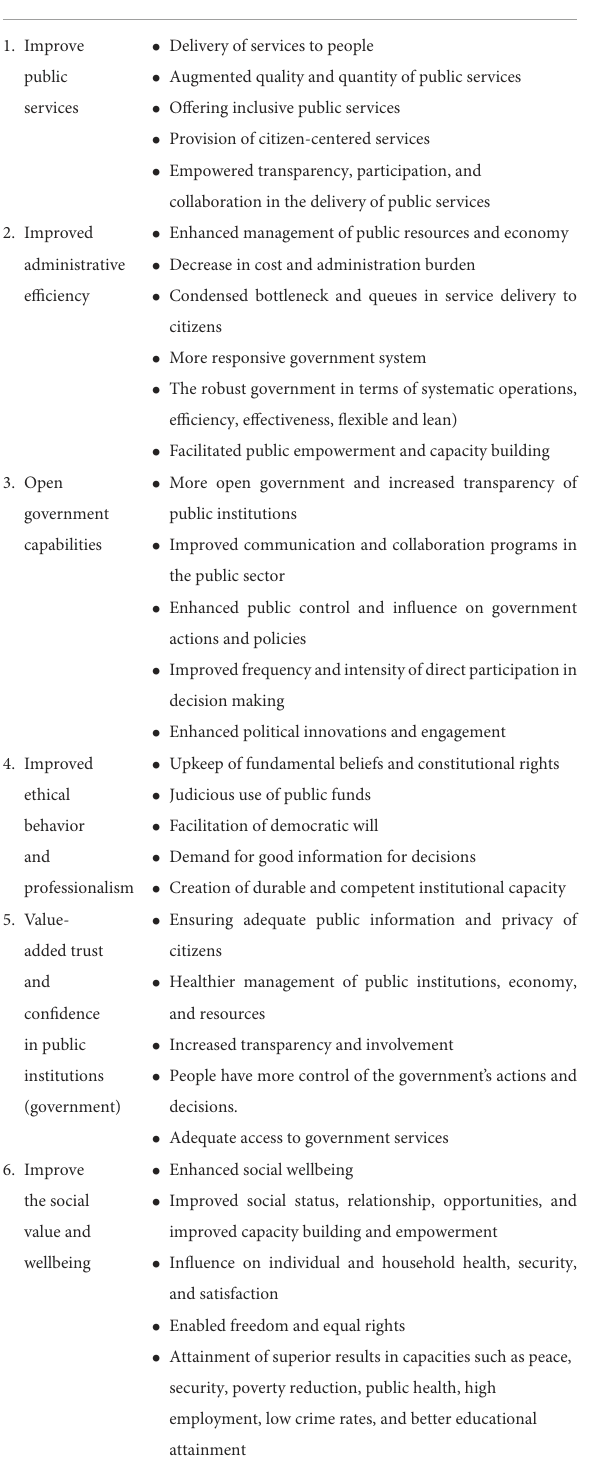
TABLE 1 Characteristics of the public value of e-government and their descriptions (Twizeyimana and Andersson, 2019).